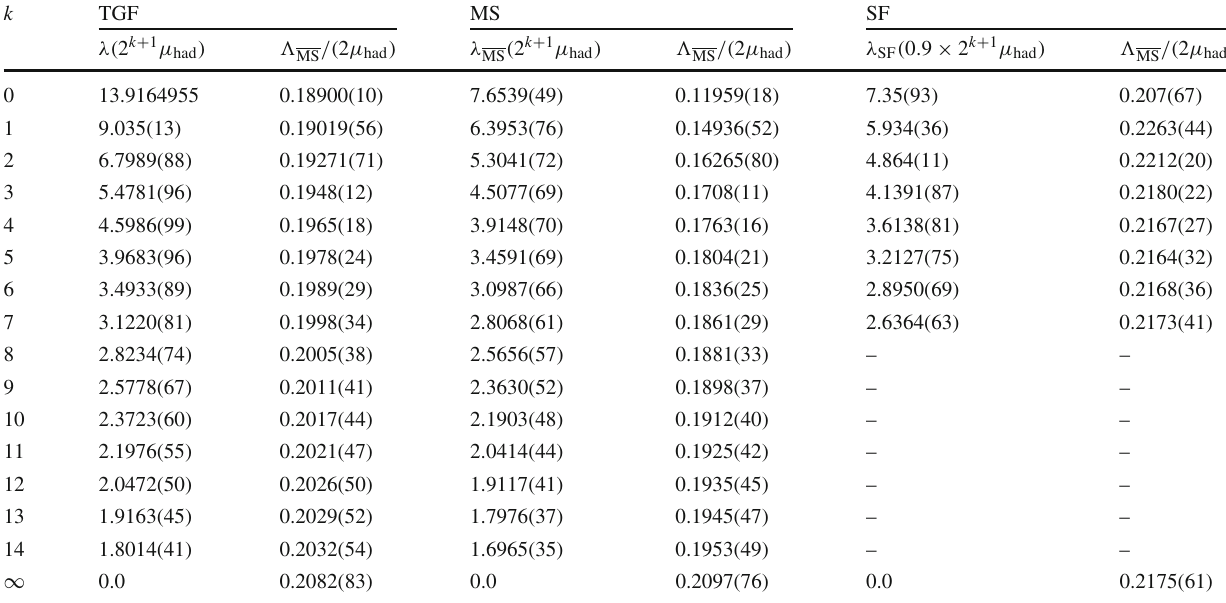
Table 2 We list the couplings along the step scaling sequence starting at λ( 2 μ had ) = 13 . 9164955, corresponding to the three different com- putation strategies. The values of (cid:2) s /( 2 μ had ) are obtained by matching